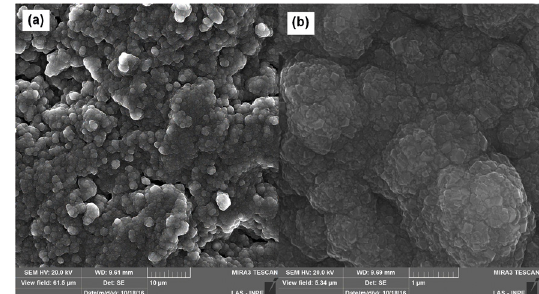
Figure 6. FEG-SEM image of diamond film on AISI 304L with SiC interlayer